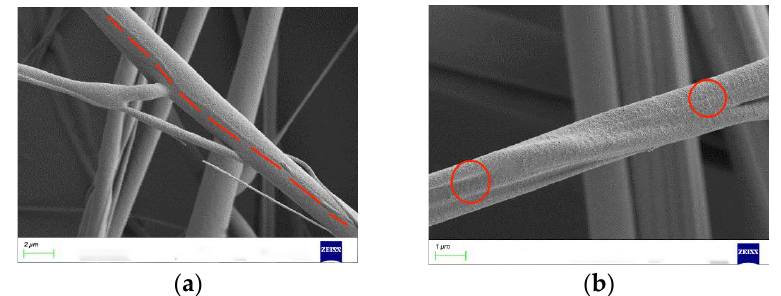
Figure 8. PEO/PVA composite nanofibers morphology with different speeds. ( a ) 1200 rpm; ( b ) 1500 rpm. When the motor speed was in the range of 1200–3000 rpm, the SEM images at 1500 rpm, 2100 rpm, and 2700 rpm were selected, as shown in Figure 9. The morphology and surface quality of PEO/PVA composite nanofibers were enhanced, and the distribution of fiber diameter was more uniform with the increase in speed. Then, the diameters of the PEO/PVA composite nanofibers collected at different rotational speeds were measured, and a histogram was generated to analyze the increasingly uniform diameter of PEO/PVA composite nanofibers. The fiber diameter decreased with the increase in rotational speed. However, as the speed continued to increase beyond this range, the uniformity of the fiber diameter distribution was less evident. At speeds above 3300 rpm, the fiber morphology deteriorated and began to break. At speeds above 3600 rpm, it no longer collected com- plete fibers at the collection rod. An optimal speed range during fiber preparation ensures an excellent surface quality and diameter distribution of PEO/PVA composite nanofibers with increasing speed, and the fiber diameter is reduced with increasing speed. Therefore, the rotational speed is one of the important elements influencing the diameter and mor- phology of PEO/PVA composite nanofibers. ( a ) ( b ) ( c )